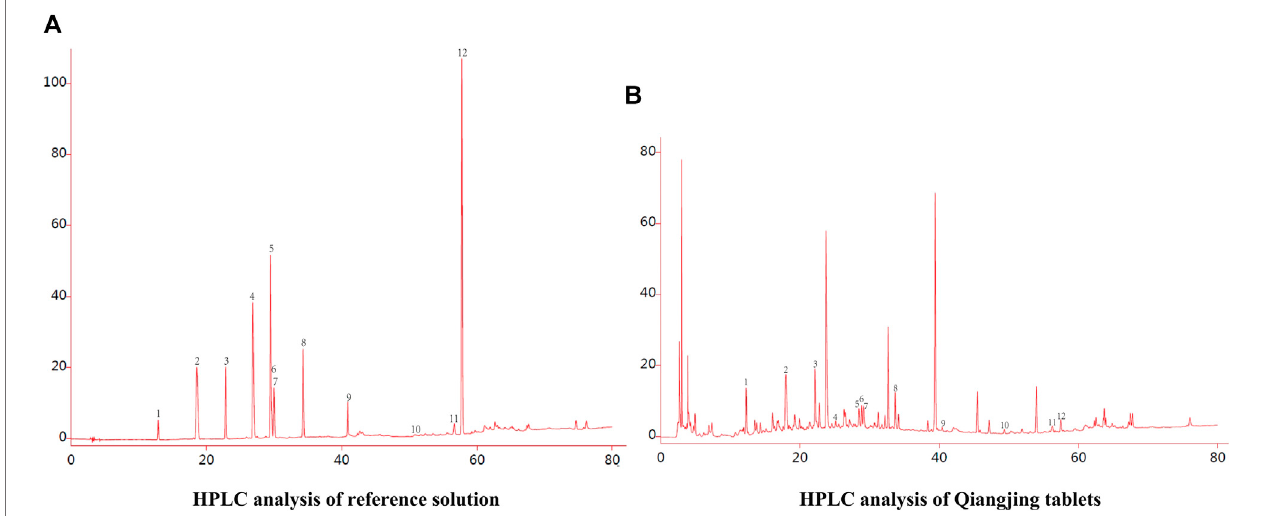
FIGURE 2 | Fingerprint spectrum analysis of Qiangjing tablets. (A) HPLC analysis of reference solution. (B) HPLC analysis of Qiangjing tablets. (1. Geniposide; 2. Mononoside; 3. Loganin;. 4. Motherwort alkaloid; 5. Mullein glycoside; 6. Hypericin; 7. Ferulic acid; 8. Xanthoside; 9. Icariin; 10. Schisandrin; 11. Ginsenoside Rg1; 12. Ginsenoside Re).